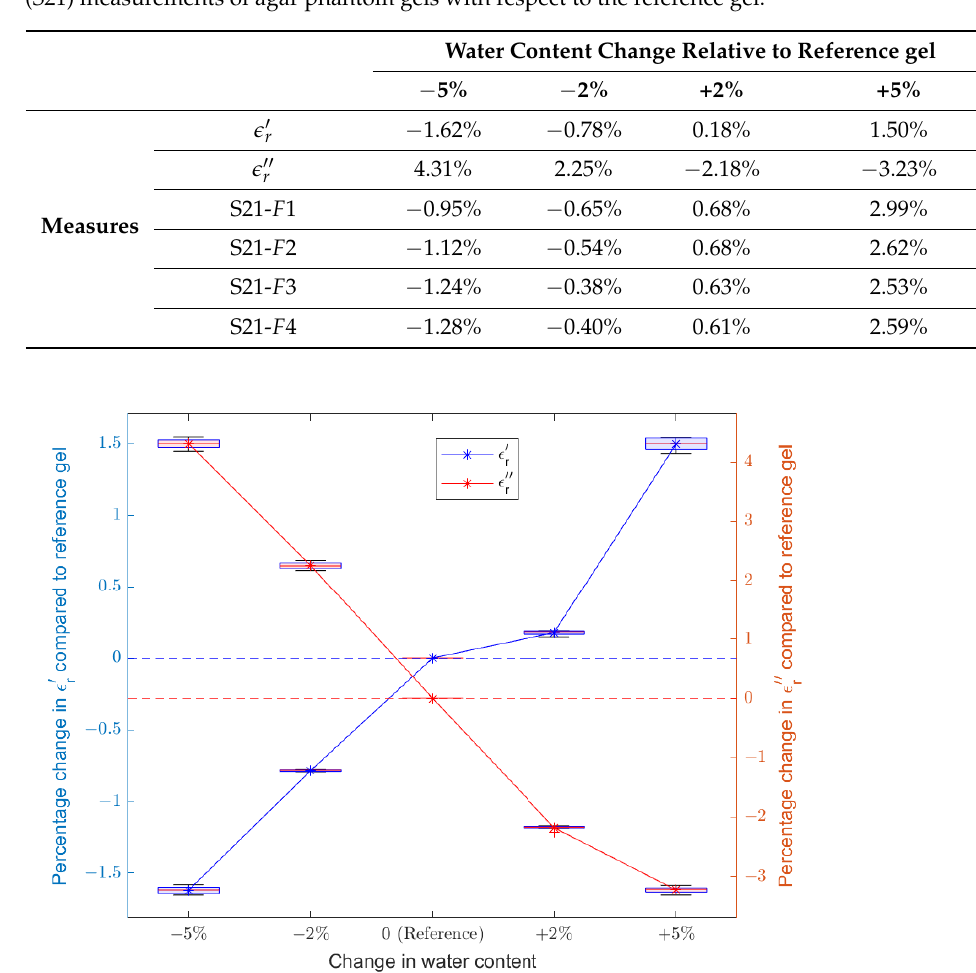
Table 2. Percentage changes in dielectric properties and electromagnetic transmission coefficient (S21) measurements of agar phantom gels with respect to the reference gel.